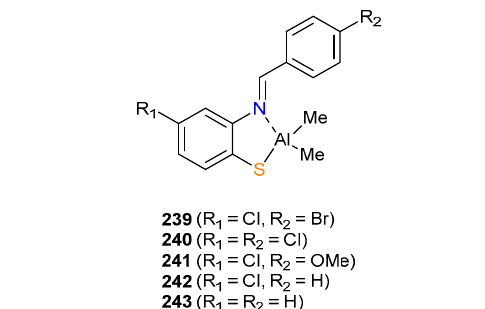
Figure 39. Five-membered ring Al complexes of N,S-Schiff bases 239–243 [117].